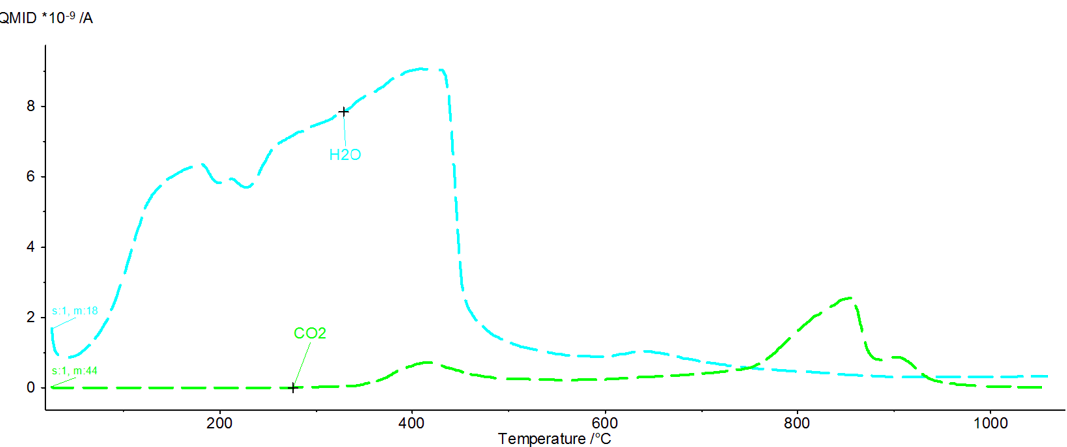
Figure 14. H 2 O and CO 2 release curves from sample P as ionic current as a function of temperature.